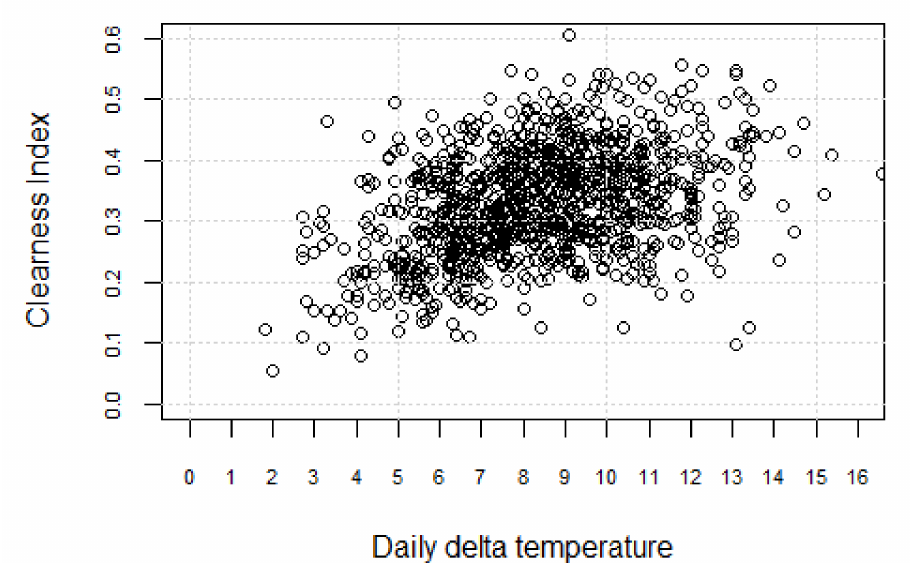
Figure 8. Daily delta of temperature–clearness index for La Josefina.